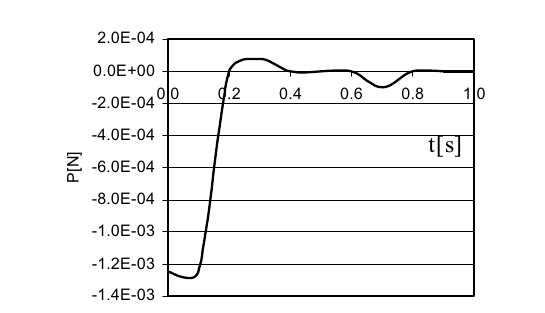
Fig. 8. Vehicle suspension optimal control [N].